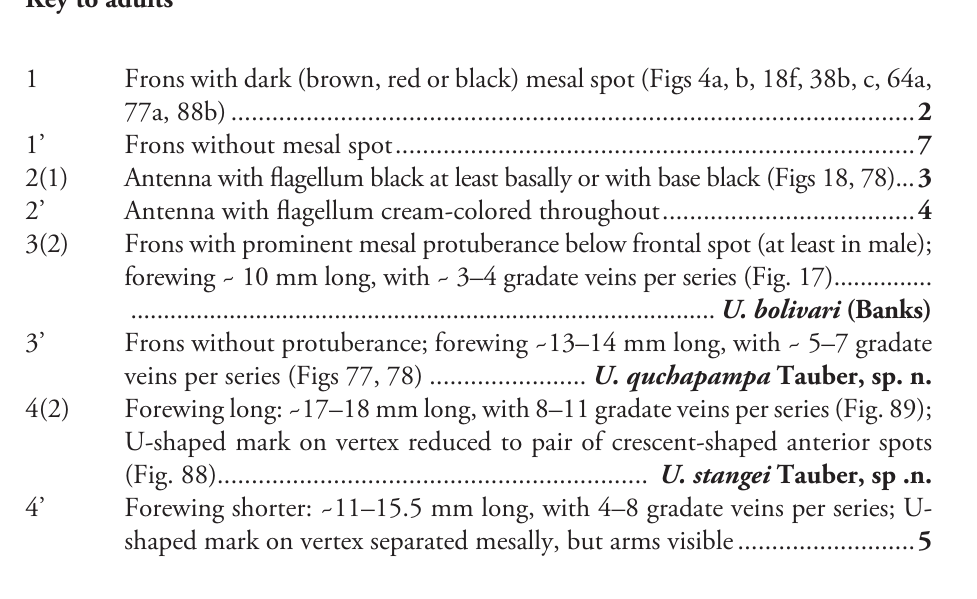
Antenna with flagellum black at least basally or with base black (Figs 18, 78)... 3 Frons with prominent mesal protuberance below frontal spot (at least in male); forewing ~ 10 mm long, with ~ 3–4 gradate veins per series (Fig. 17) ............... Frons without protuberance; forewing ~13–14 mm long, with ~ 5–7 gradate Forewing long: ~17–18 mm long, with 8–11 gradate veins per series (Fig. 89); U-shaped mark on vertex reduced to pair of crescent-shaped anterior spots (Fig. 88)............................................................... U. stangei Tauber, sp .n. 4’ Forewing shorter: ~11–15.5 mm long, with 4–8 gradate veins per series;